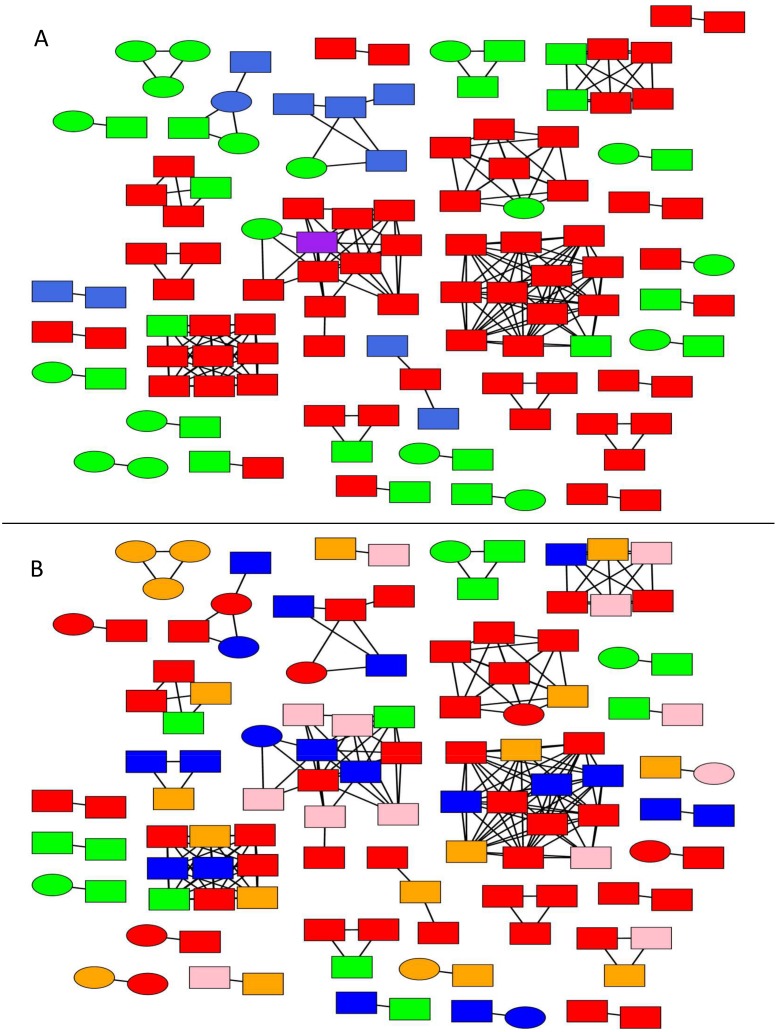
Inferred HIV Transmission Clusters.HIV-1 transmission clusters (networks) identified in the region of South-East Austria. Sex of the individuals (nodes) is indicated by shape: square (men) and circle (women) 1A. Nodes are colored by their reported risk factor: red (men who have sex with men [MSM]), green (heterosexual), blue (injection drug use [IDU]) and purple (MSM and IDU), respectively. All edges represent a genetic distance ≤1.5% separating nodes. 1B. Here, nodes are colored according to the region of residence in red (Graz City), pink (Suburban Graz), green (Eastern Styria), blue (Northern Styria) and orange (Southwestern Styria).